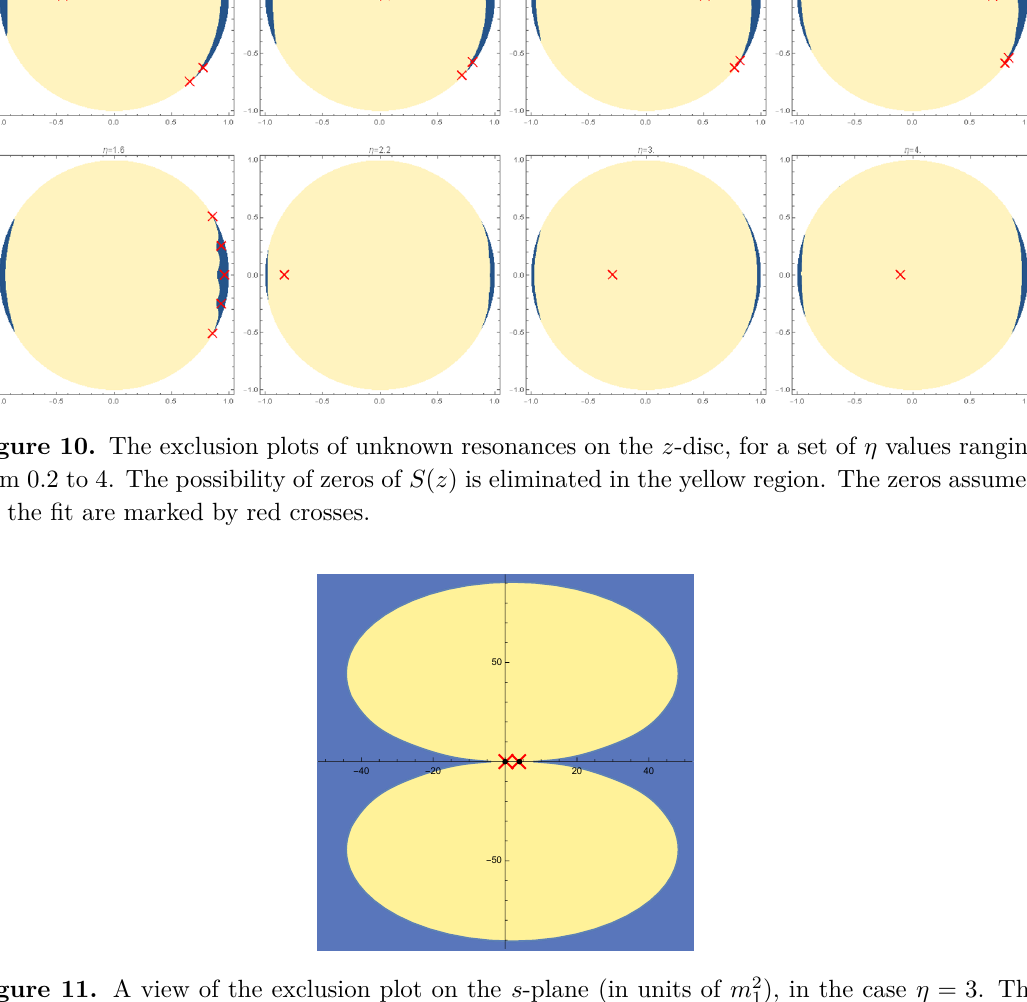
), in the case η = 3 . The 1